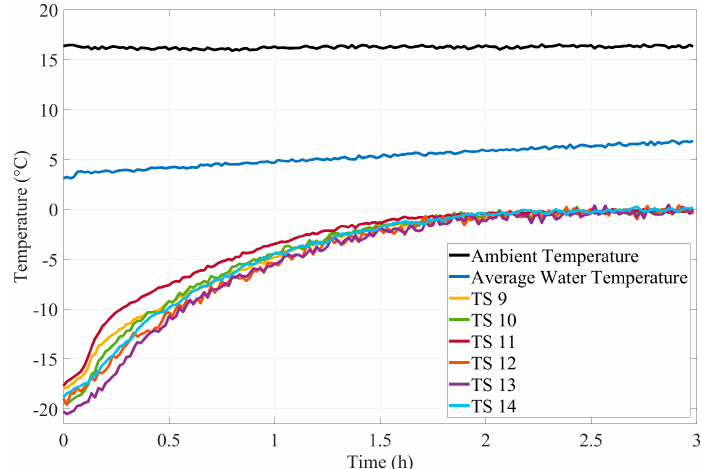
Figure 13. Time history of the temperature profile of test Exp. 3, for the embedded temperature sensors as well as for the water and ambient air temperature; positions are according to Figure 6.